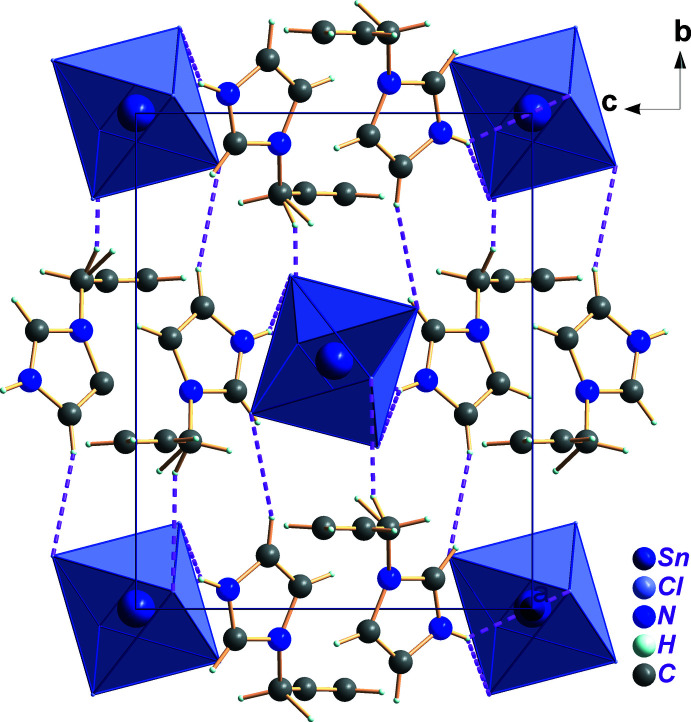
Crystal packing of (C6H9N2)2[SnCl6] viewed along the a axis, showing the N—H⋯Cl and C—H⋯Cl hydrogen bonds (dashed lines).